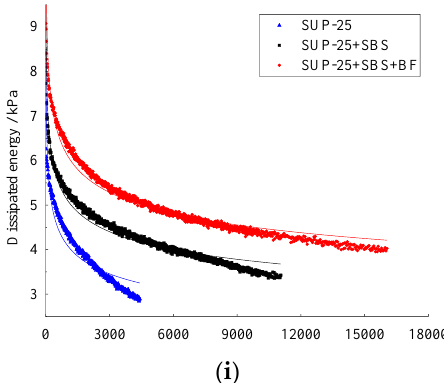
Figure 7. Dissipated energy: ( a ) SMA-13 (450 με) , ( b ) SMA-13 (650 με) , ( c ) SMA-13 (850 με) , ( d ) SUP-20 (450 με) , ( e ) SUP-20 (650 με) , ( f ) SUP-20 (850 με) , ( g ) SUP-25 (450 με) , ( h ) SUP-25 (650 με) and ( i ) SUP-25 (850 με) .